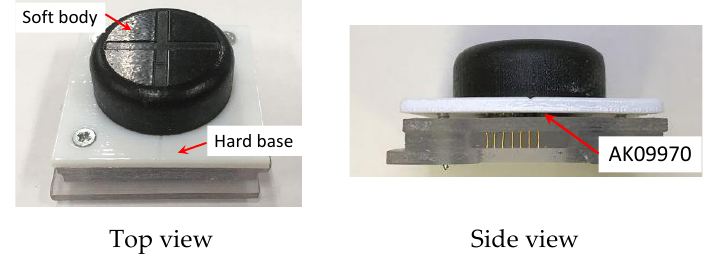
Figure 8. Fabricated fingertip.